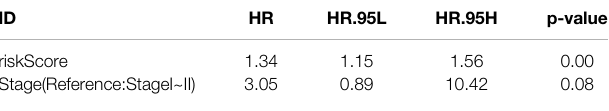
TABLE 4 | Multivariate Cox regression analysis of high-risk and low-risk